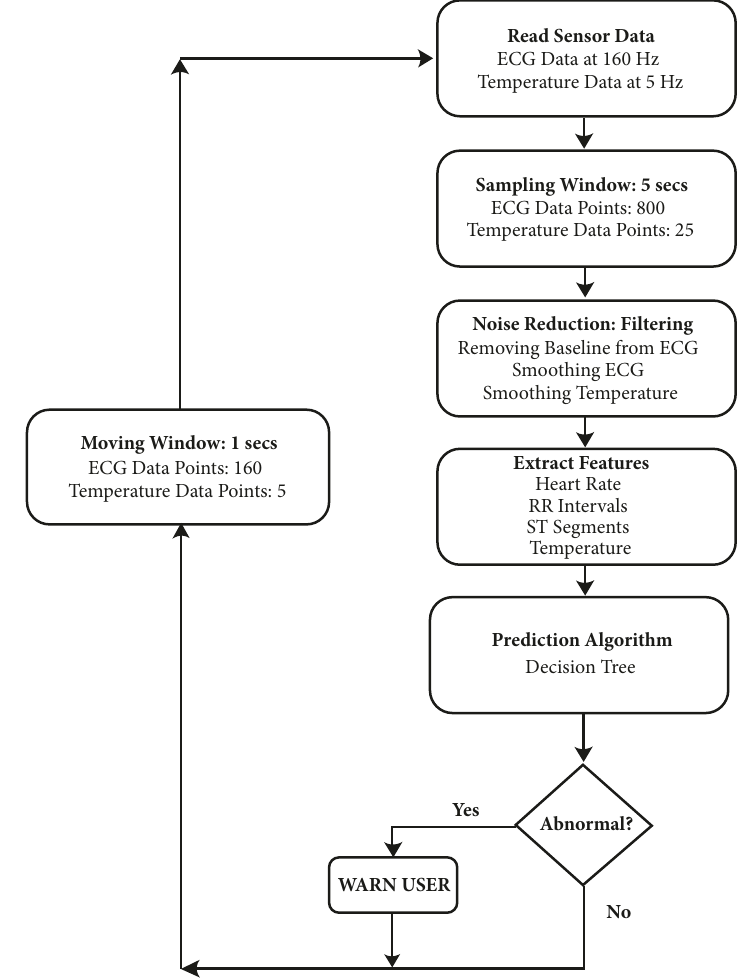
Figure 13: Flow diagram of our